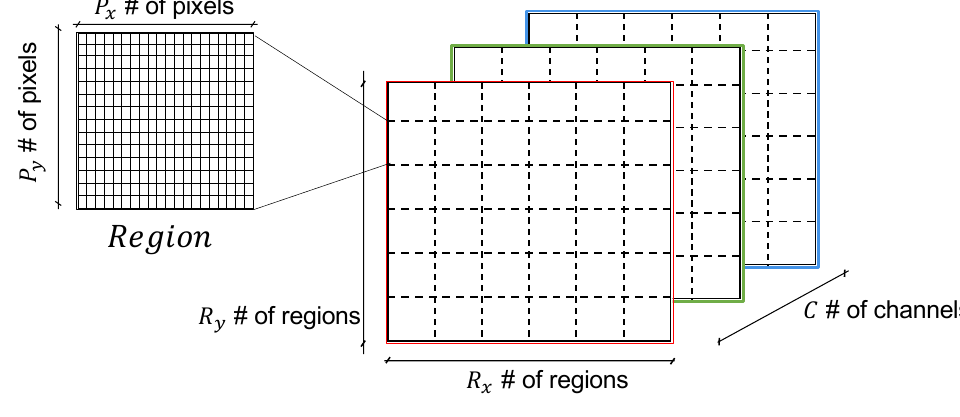
Figure 3. Canvas & Regions